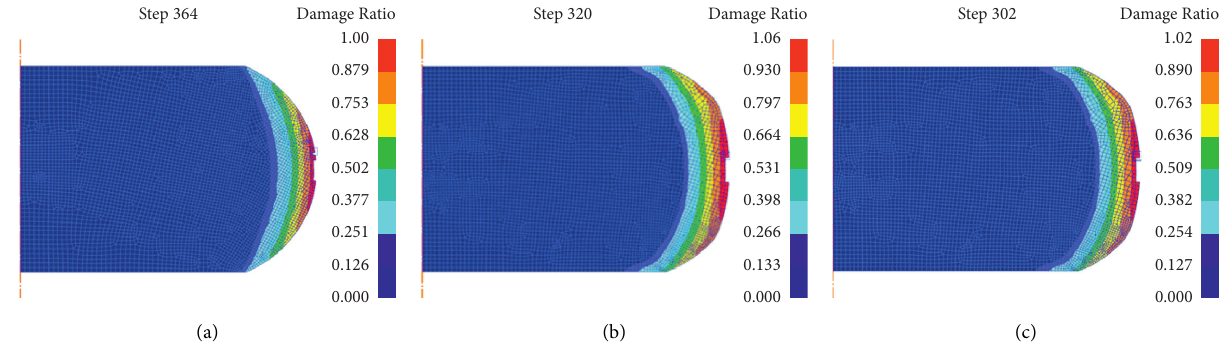
Figure 9: Occurrence of cracks at 1373K and the stroking speed of 5mm/s for the critical height reduction ratios of (a) 61.8% (CUP-20), (b) 53.3% (TUP-30), and (c) 50.3% (TUP-36).